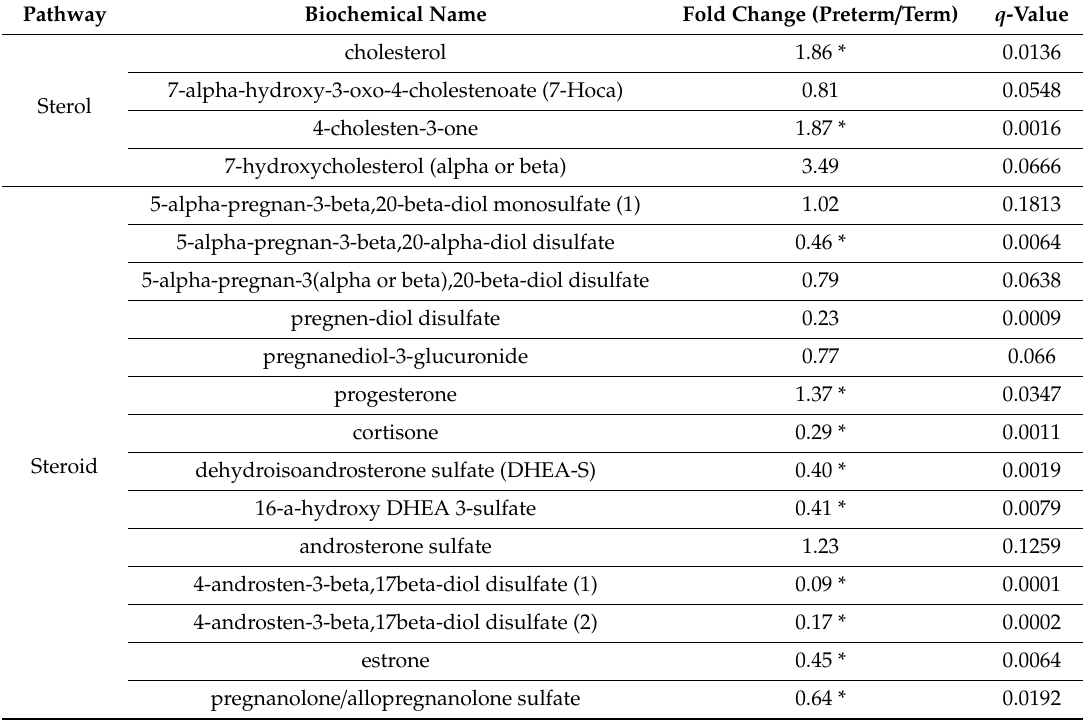
Table 4. Fold change in sterols and steroids in